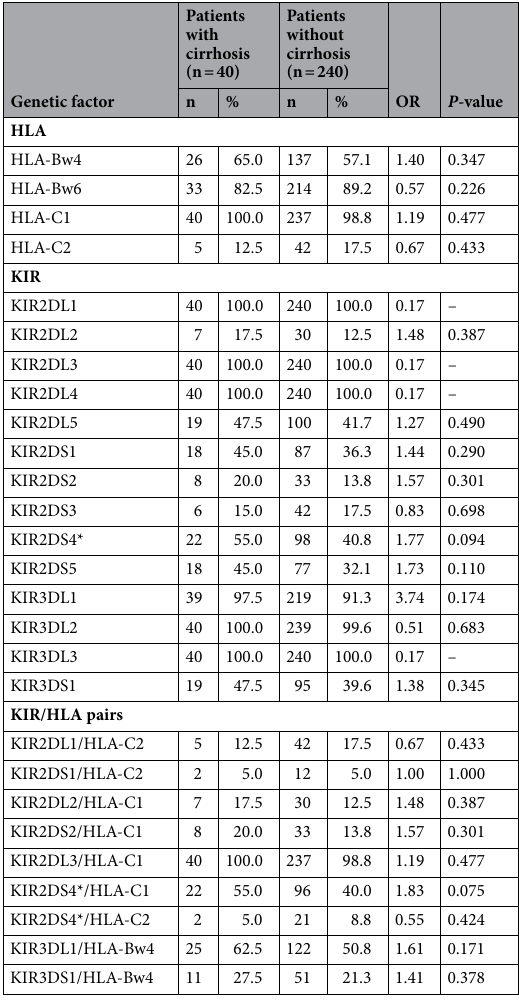
Table 2. Frequency of HLA alleles, KIR genes, and KIR/HLA pairs in patients with and without cirrhosis. HLA human leukocyte antigen, KIR killer immunoglobulin-like receptor, OR odds ratio. *Full-length KIR2DS4 was